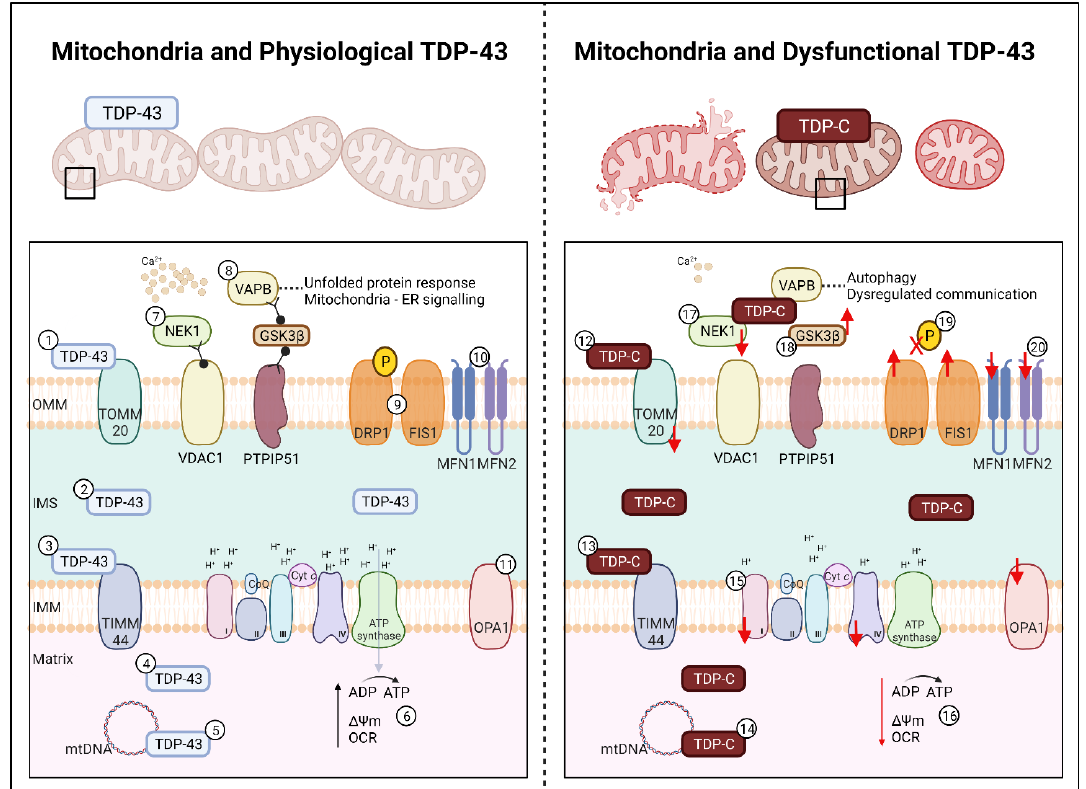
Figure 2. Effect of TDP-43 on Mitochondria in ALS. Left : Mitochondria and Physiological TDP-43. In healthy cells length TDP-43 localises to (1) TOMM20 on the OMM, (2) within the IMS and to (3) TIMM44 of the IMM, (4) freely within the matrix, and (5) regulates mtDNA for OXPHOS complex expression. (6) OXPHOS complexes I-IV and ATP synthase facilitate ATP production, facilitating the maintenance of the membrane potential and a healthy oxygen consumption rate. (7) Mitochondrial proteins NEK1 and VDAC1 support calcium signalling. (8) The mitochondrial-endoplasmic reticulum complex, PTPIP51-GSK3 β -VAPB ensures proper protein folding and organelle communication. The mitochondrial dynamics related proteins for (9) fission on the OMM (DRP1, FIS1) and (10) fusion on the OMM (MFN1, MFN2) and the (11) IMM (OPA1) facilitate mitochondrial network homeostasis and regulation. Right : Mitochondria and Dysfunctional TDP-43. In ALS, fragmented TDP of 25 kDa and 35 kDa (denoted as TDP-C) localises to (12) TOMM20 and (13) TIMM44 causing downregulation and loss of mitochondria. TDP-C also co-localise to (14) mtDNA causing fragmentation, leading to a (15) loss of OXPHOS complex I and IV. (16) Loss of complex regulation leads to a decrease in ATP production, driving a loss of membrane potential and oxygen consumption rate. (17) TDP-C leads to a decrease in NEK1, causing a loss of VDAC1 and calcium signalling. (18) Localisation of TDP-C to GSK3 β causes the loss of mitochondrial-endoplasmic reticulum signalling resulting in protein folding dysfunction and loss of organelle communication, which in turn leads to autophagy. Further impacts of TDP-C results in (19) DRP1 de-phosphorylation leading to (20) increased fission and decreased fusion. Upregulation of FIS1 and downregulation of MFN1, MFN2, and OPA1 are also observed in TDP-43 models leading to increased fission and mitochondrial fragmentation and subse- quent cellular death. TDP-C; TDP-43 C-terminal fragments, OMM; outer mitochondrial membrane, IMS; inter-membrane space, IMM; inner mitochondrial matrix, ATP; adenosine triphosphate, CoQ; Coenzyme Q; Cyt c ; cytochrome c . Created with BioRender.com accessed on 12 July